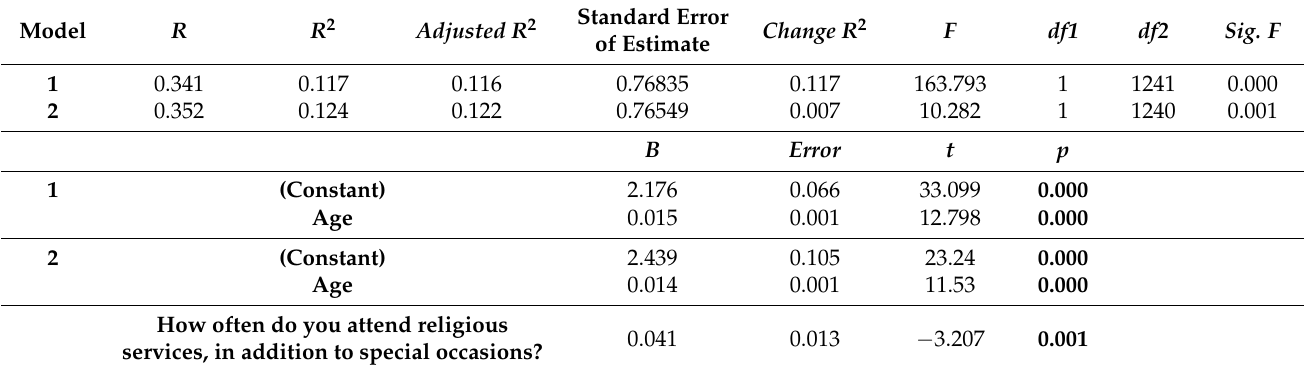
Table 8. Multiple linear regression 2: Contribution to second-order dimension openness to